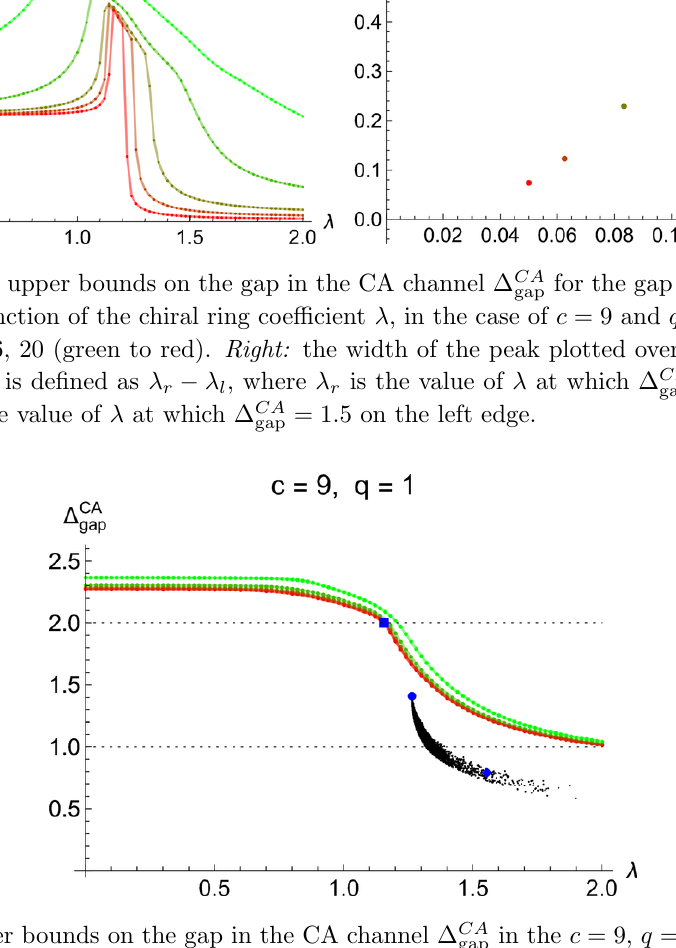
in the c = 9, q = 1 case. The green gap ) for the T 6 = Z 3 gap in this case. The blue gap = 6 . gap 5